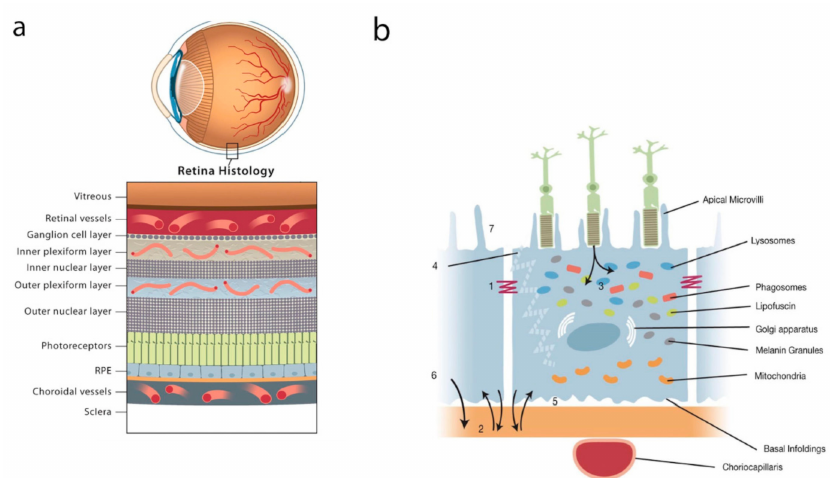
Figure 1. ( a ) Topographic relationship of the retinal pigment epithelium (RPE) within the retina. RPE anatomy and function. ( b ) The functions of the RPE are labelled as follows: (1) Tight junction (TJ) of the outer blood retina barrier (oBRB); (2) Transport of fluid, nutrients, and metabolites (paracellular and transcellular); (3) Phagocytosis of photoreceptor outer segments (POS); (4) Absorption of scattered light; (5) Retinal adhesion; (6) Paracrine secretion (including vascular endothelial growth factor (VEGF)); (7) Maintaining balance across the sub-retinal